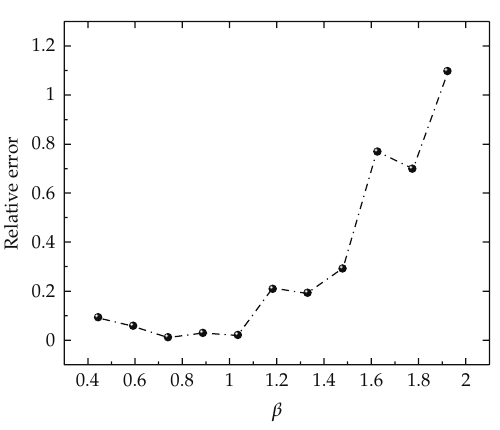
Figure 11: Relative error between 4th-order HAM approximation and numerical solutions for the fre- quency ω